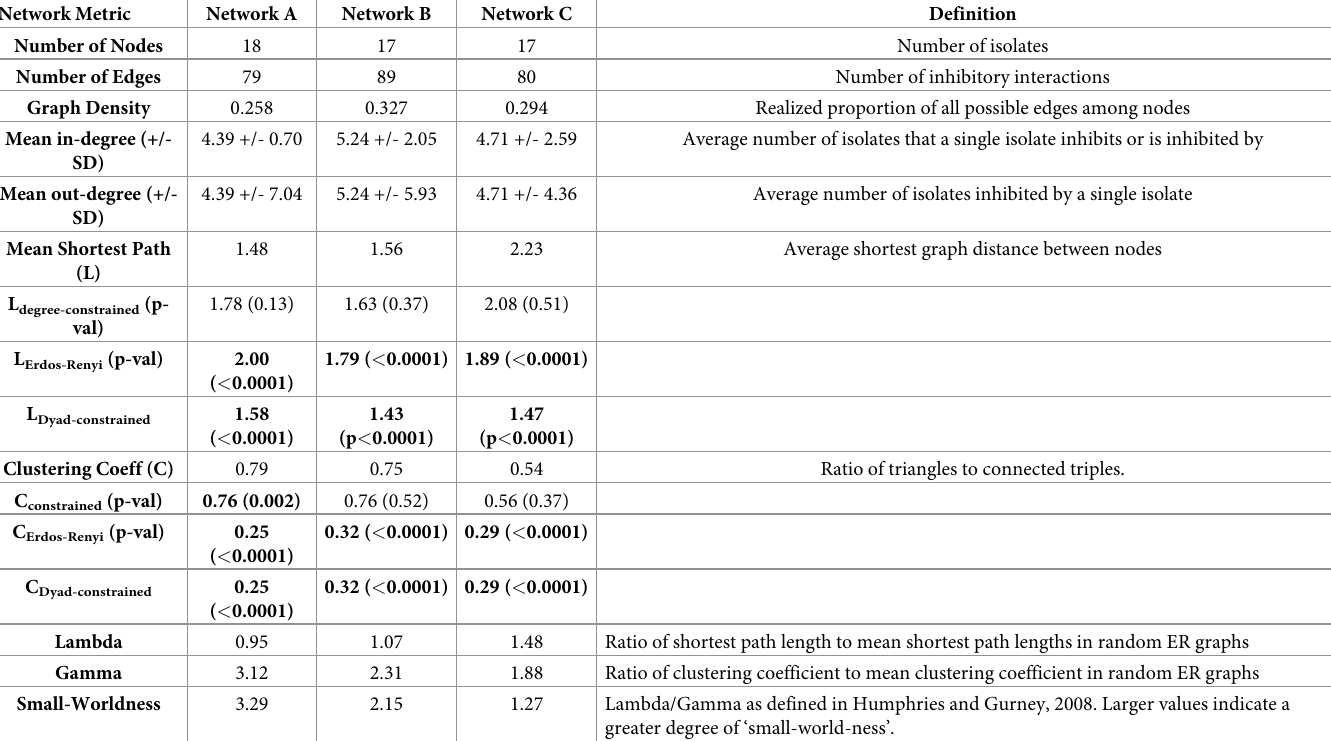
Table 1. Network metrics of real networks of coevolved Streptomyces inhibitory interactions and those of random network models. Network Metric Network A Network B Network